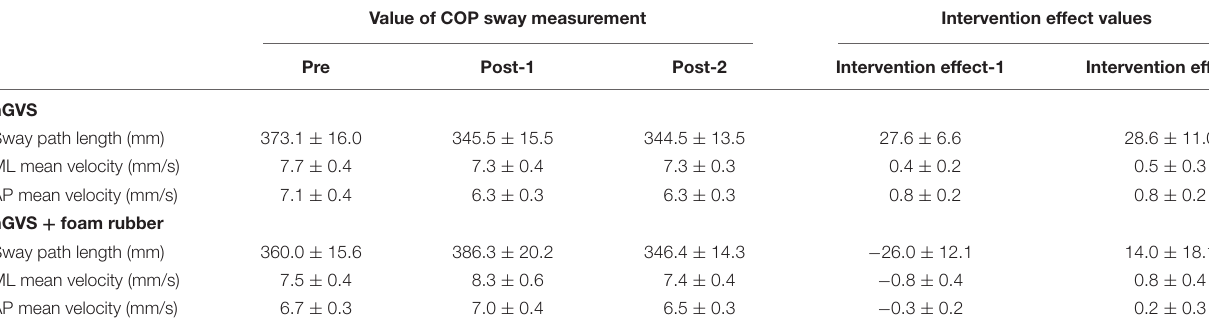
TABLE 2 | The COP sway values and intervention effects in Experiment 1.